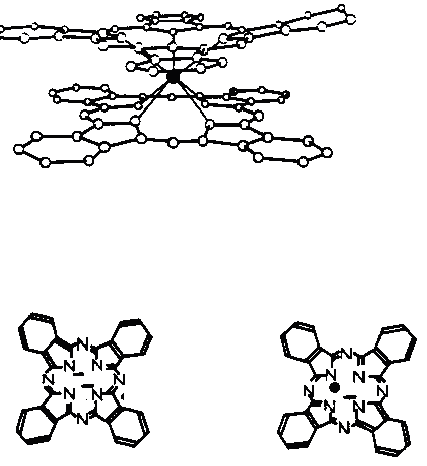
Figure 1. Molecular structure of lutetium bisphthalocyanine (LuPc 2